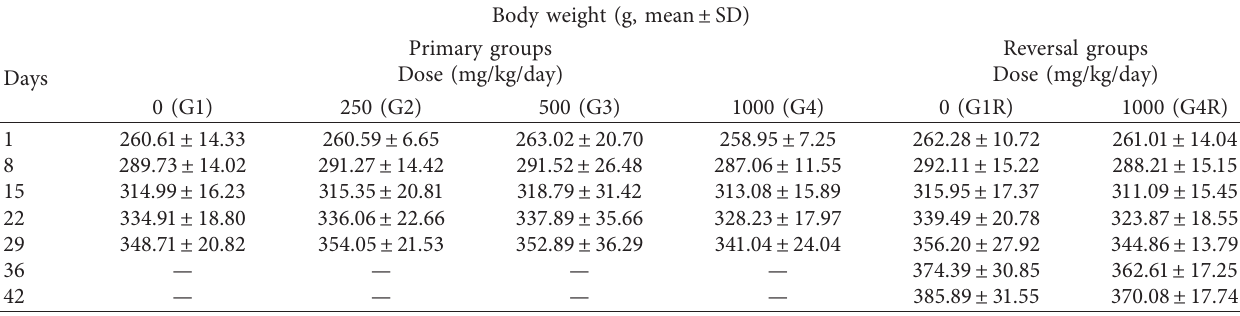
Table 3: Effect of oral administration of GMCT on body weight of male Wistar rats.